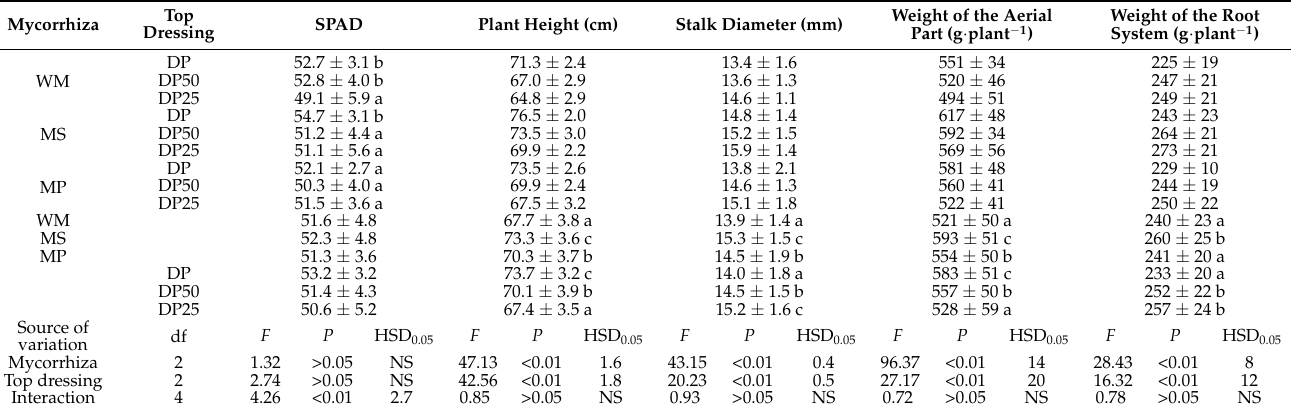
Table 3. SPAD leaf greenness index and biometric characteristics of sweet pepper plants; on average across three years